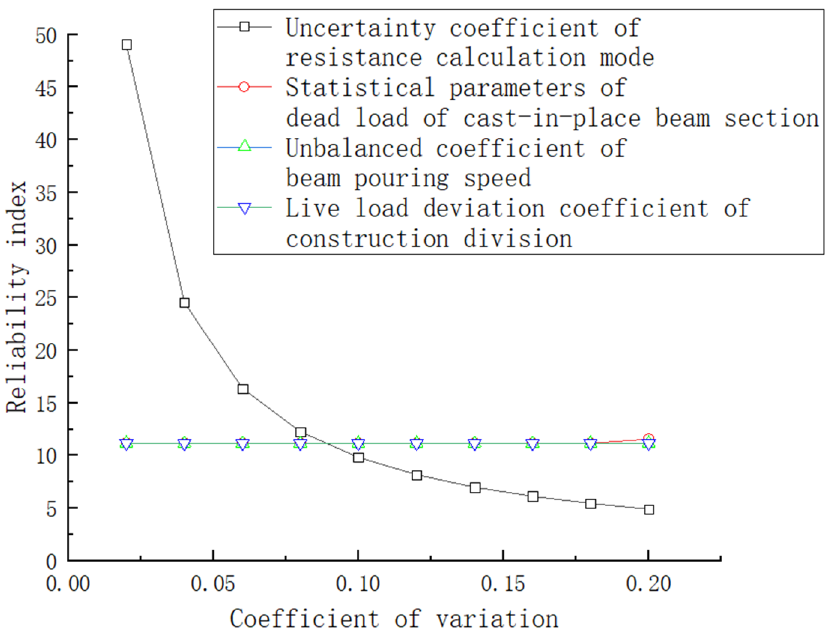
Figure 4. Effect of coefficient of variation of each parameter on stability reliability index under combination I.